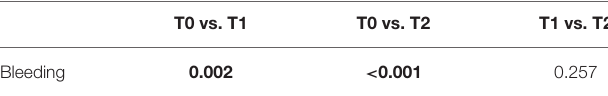
TABLE 5 | Post-hoc pairwise comparisons clinical characteristics of the sample using McNemar’s test. T0 vs. T1 T0 vs. T2 T1 vs. T2 Bleeding 0.002 < 0.001 0.257 Bold values denote statistical